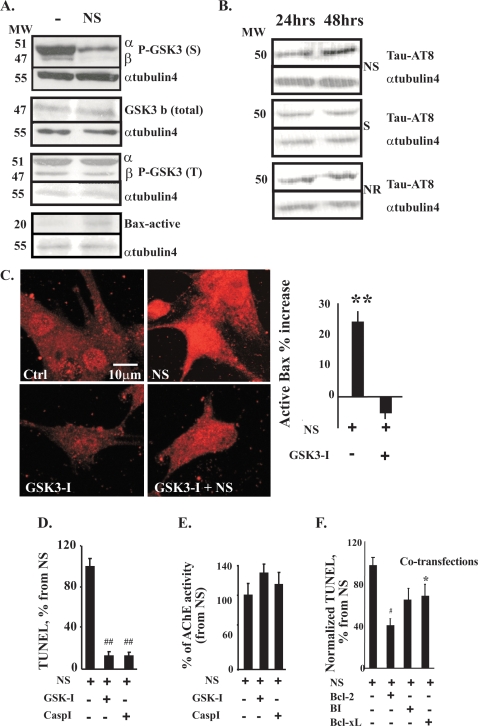
N-AChE-S induces suppressible GSK3-activation, Tau hyper-phosphorylation and Bax activation.A. Immunoblots. N-AChE-S reduces serine-phosphorylated P-GSK3 while maintaining unchanged total GSK3β and tyrosine phosophorylated GSK3, and elevating active-Bax. B. Tau hyper-phoshorylation: N-AChE-S, but neither AChE-S nor N-AChE-R induces progressive increases in hyper-phosphorylated Tau (Tau AT8). Alpha tubulin 4 served as reference. C. N-AChE-S-inducible GSK3 dephosphorylation facilitates Bax activation. Shown are micrographs of N-AChE-S transfected cells with elevated phosphorylated Bax labeling compared to U87MG control (Ctrl) cells. GSK3 inhibition suppresses this labeling. Quantification: % increase in Bax labeling of NS overexpressing cells, preventable under GSK-I (SB316763) treatment (**p = 0.00009 Student's t test). D. GSK3 and Caspase inhibition suppress N-AChE-S-induced apoptosis. % TUNEL labeling of N-AChE-S transfected cells. Note that 5 µM SB316763 (GSK3-I) and 80 µM Z-VAD-FMK (caspase-I) reduced apoptosis. (GSK-I p = 0.000013, Casp3-I p = 9×10−11 Student's t test). E. GSK3 and Caspase inhibitors do not affect AChE catalytic activity. F. Bcl proteins suppress N-AChE-S-induced apoptosis: U87MG cells co-transfected with N-AChE-S and Bcl-2 (# p = 0.00001), BI (*p = 0.03), or Bcl-XL (p = 0.054 Student's t test) showed variably suppressed TUNEL labeling.